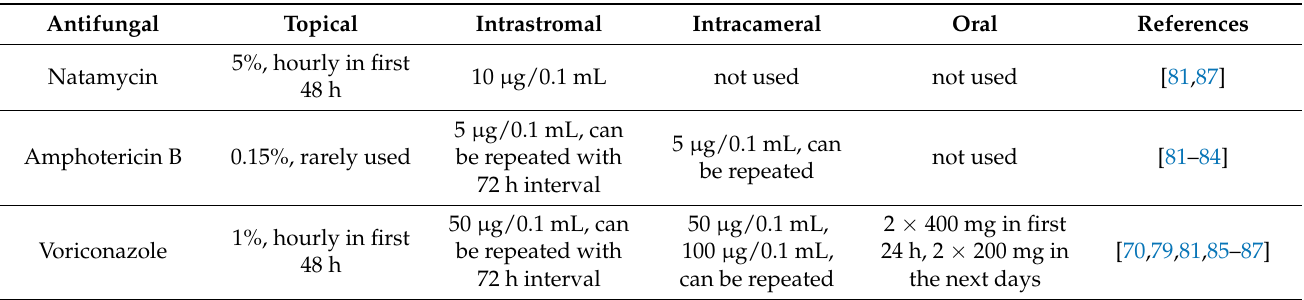
Table 1. Dosages and methods of administration of the most commonly used antifungals. Antifungal